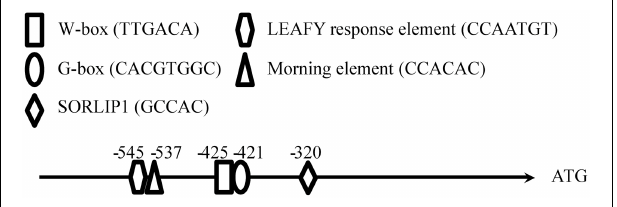
FIGURE 2 | Sequence analysis of the QH6 promoter and the construction of different promoter truncations driving GUS expression in Arabidopsis thaliana . The sequence from − 800 bp to the QH6 translation initiation site was searched for known regulatory elements in PLACE and NSITE-PL databases to identify any known motifs, as described in Materials and Methods